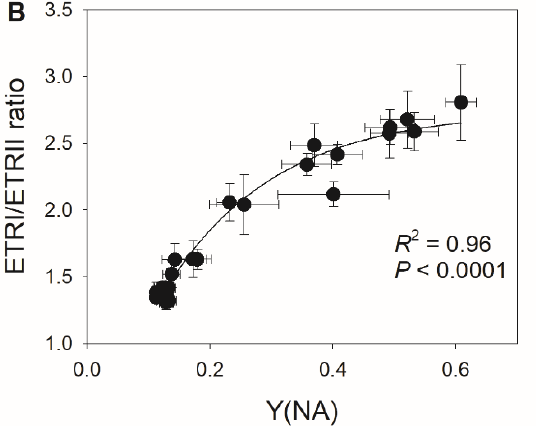
Figure 6. Relationships between ( A ) Y(NA) and ETRI–ETRII and between ( B ) Y(NA) and the ETRI/ERTII ratio during the high light phases under fluctuating light in M. alba leaves. Data are shown as mean ± SE ( n = 6).